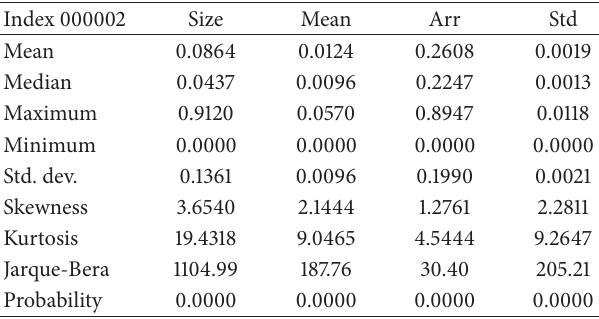
Table 1: Descriptive statistics for index jump